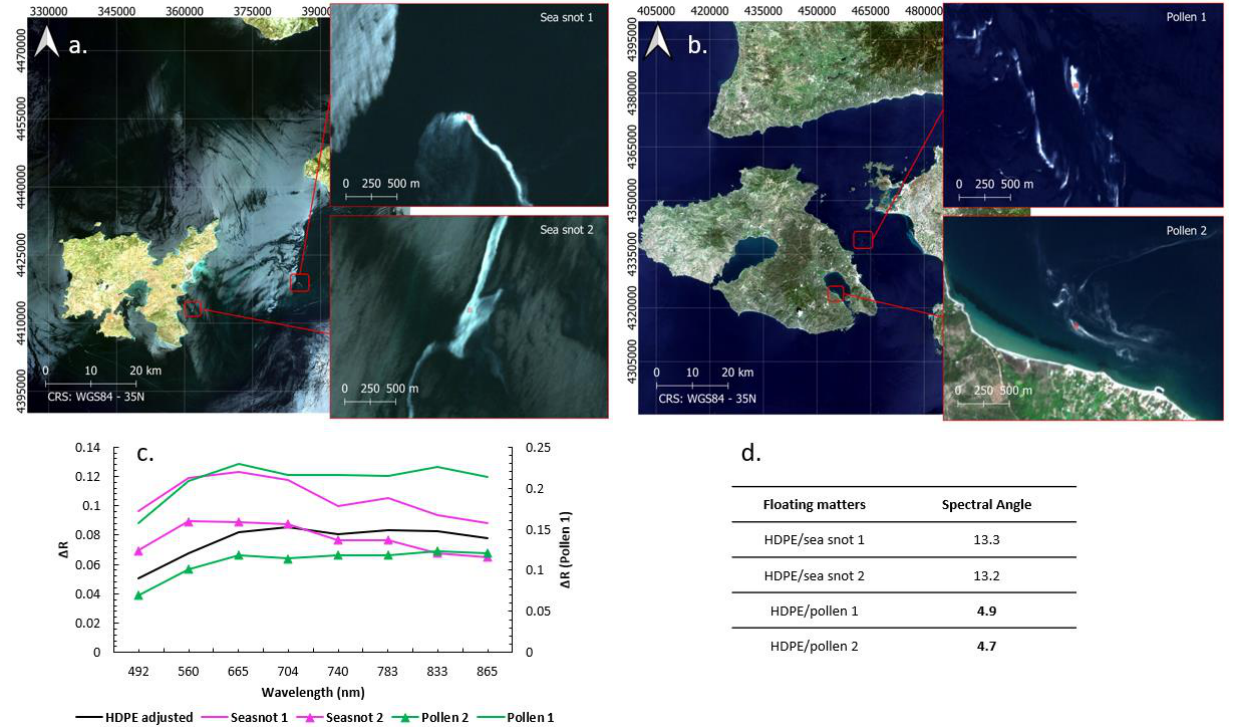
Figure 5. ( a ) Location map of the sea snot accumulations off the east coast of Lemnos Island on 20210624. The red squares indicate the location of the 5 × 5 pixel averages. ( b ) Location map of the pollen accumulations in the vicinity of the Island of Lesvos in 20220427. The red squares indicate the location of the 5 × 5 pixel averages. ( c ) Spectral comparison plots for sea snot, pollen, and the HDPE target in the 490–865 nm range. The HDPE profile magnitude has been adjusted to the average 833 nm reflectance of the central HDPE target pixel, essentially retaining the same spectral shape but increasing the magnitude. ( d ) Spectral angles between HDPE-sea-snot and HDPE-pollen. The spectral angle has been computed for an eight-band combination (492, 560, 665, 704, 740, 780, 833, 865 nm).